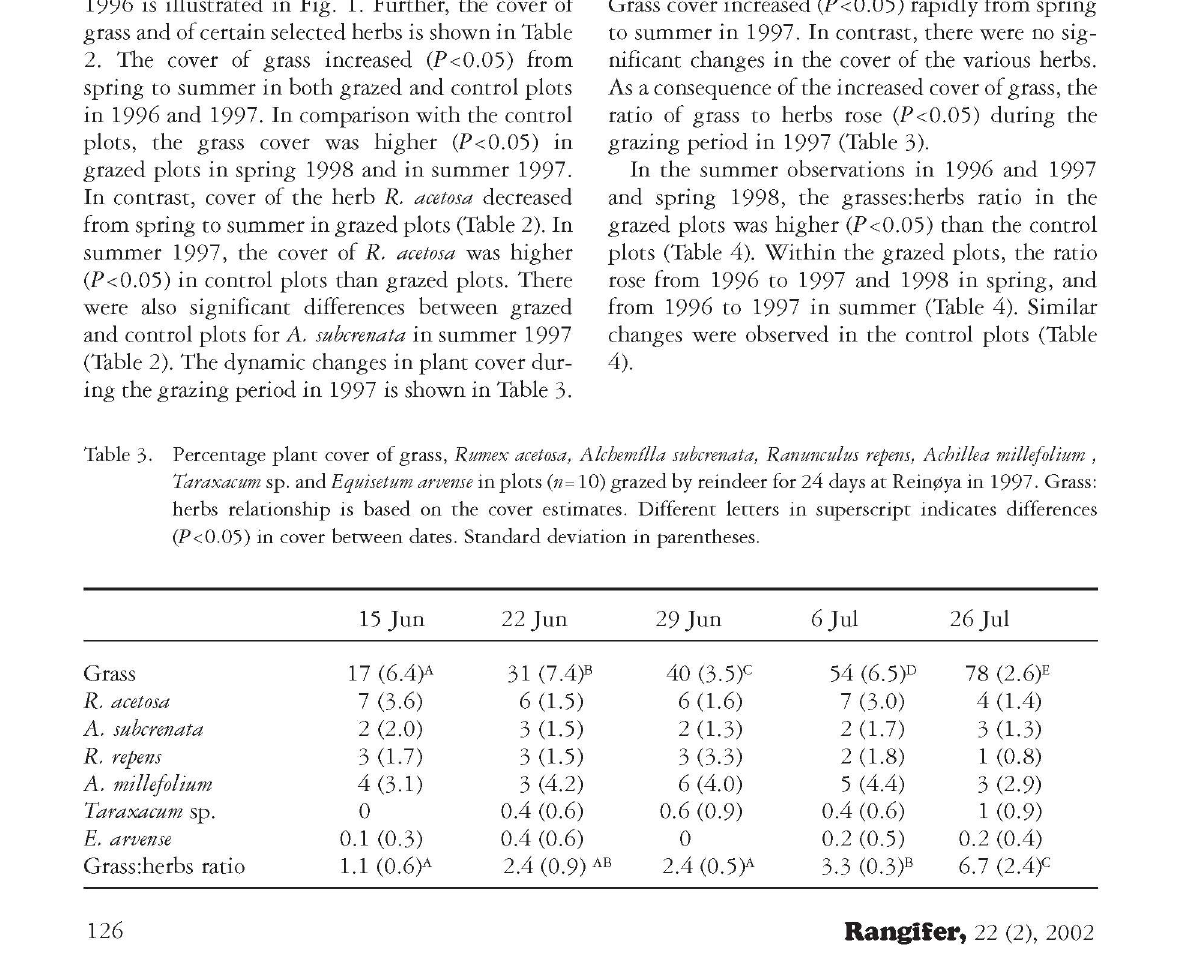
Fig. 1. Photo to the left, plots ungrazed for one week; photo to the right, plots grazed by reindeer for one week at Reinøya in mid June 1996.